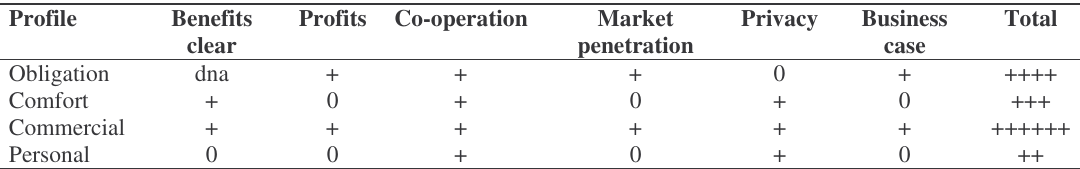
Table 3. Profile scores on